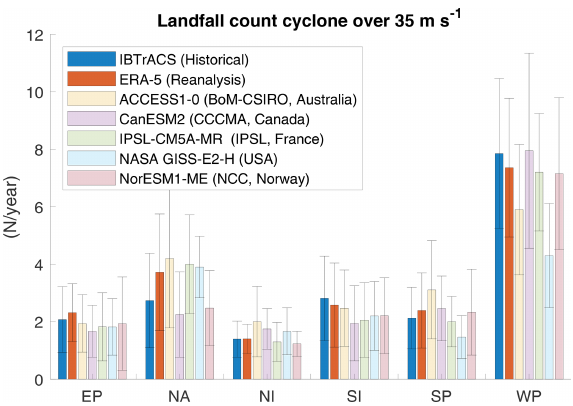
Figure 3. Number of tropical cyclones over 35ms − 1 making land- fall simulated using Bloemendaal et al. (2020) parameters over the historical period (1980–2010).